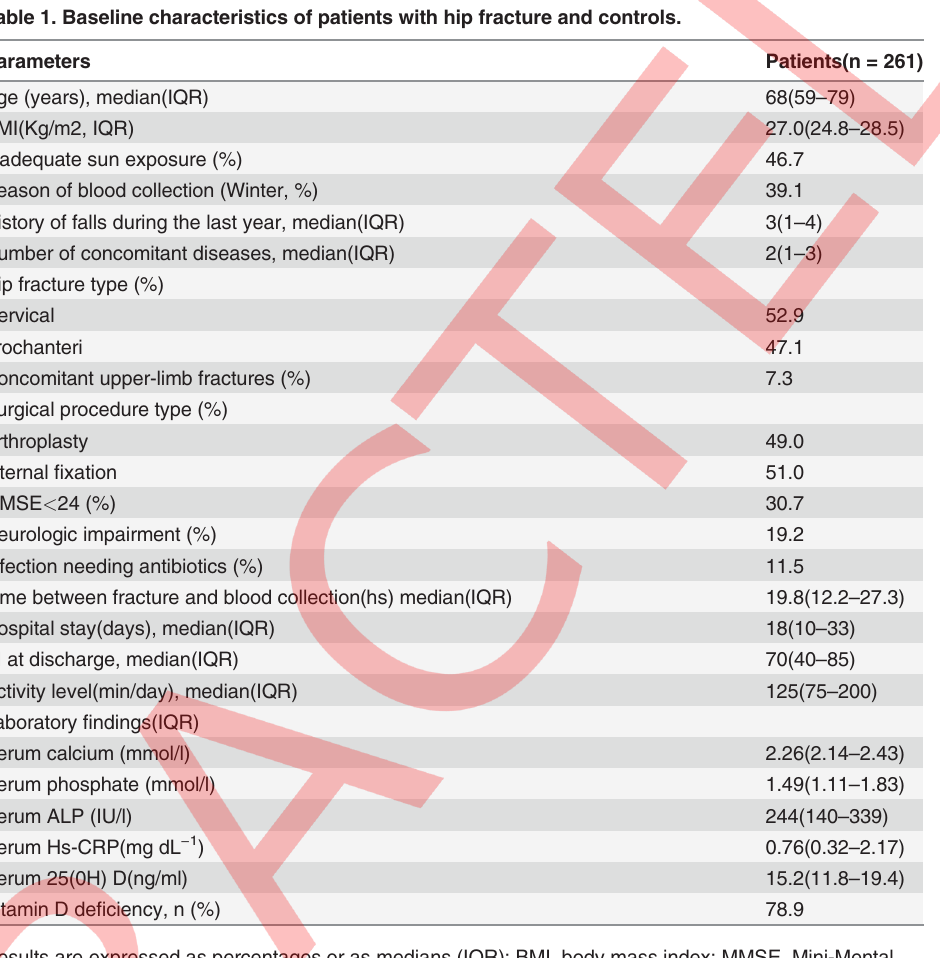
Table 1. Baseline characteristics of patients with hip fracture and